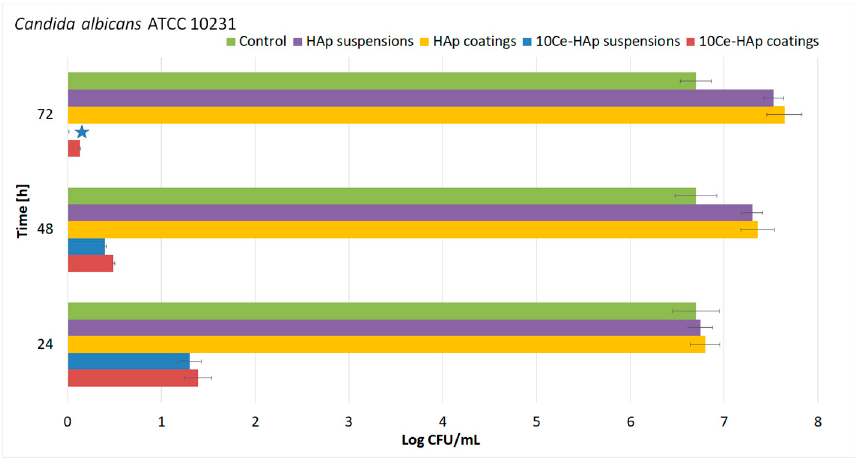
Figure 9. The graphical representation of the Log colony-forming units (CFU)/mL as a function of time of exposure to HAp and 10Ce-HAp suspensions and coatings at different time intervals. The results are presented as means ± standard error of the mean of two independent experiments. The data were statistically analyzed by using a t-test, p ≤ 0.05 was accepted as statistically